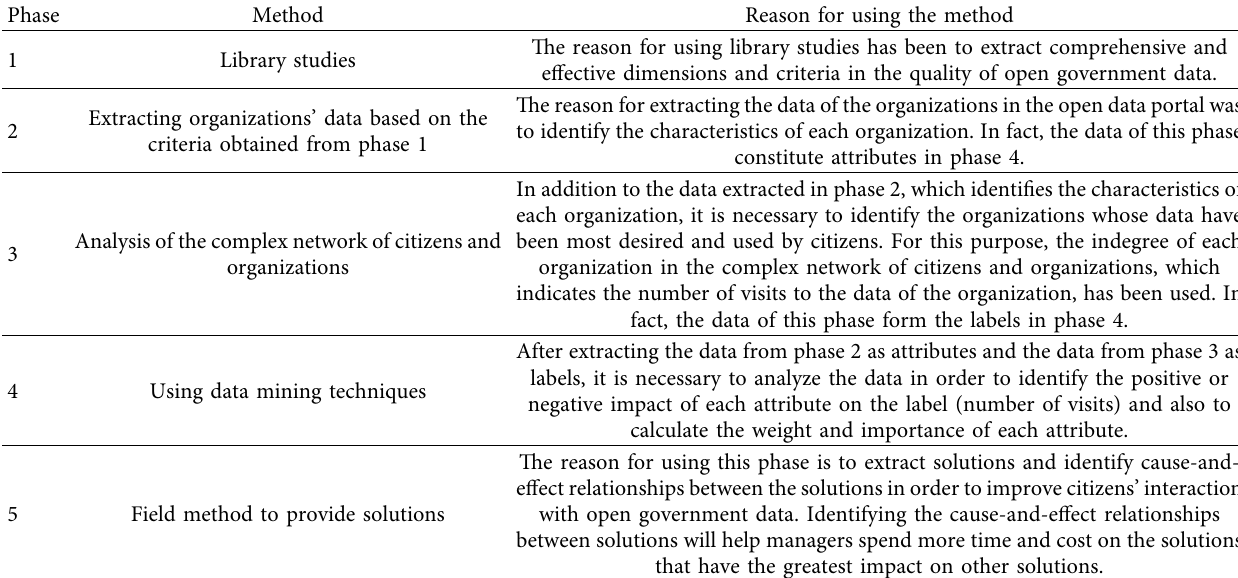
Table 1: Reasons for using each method in the research